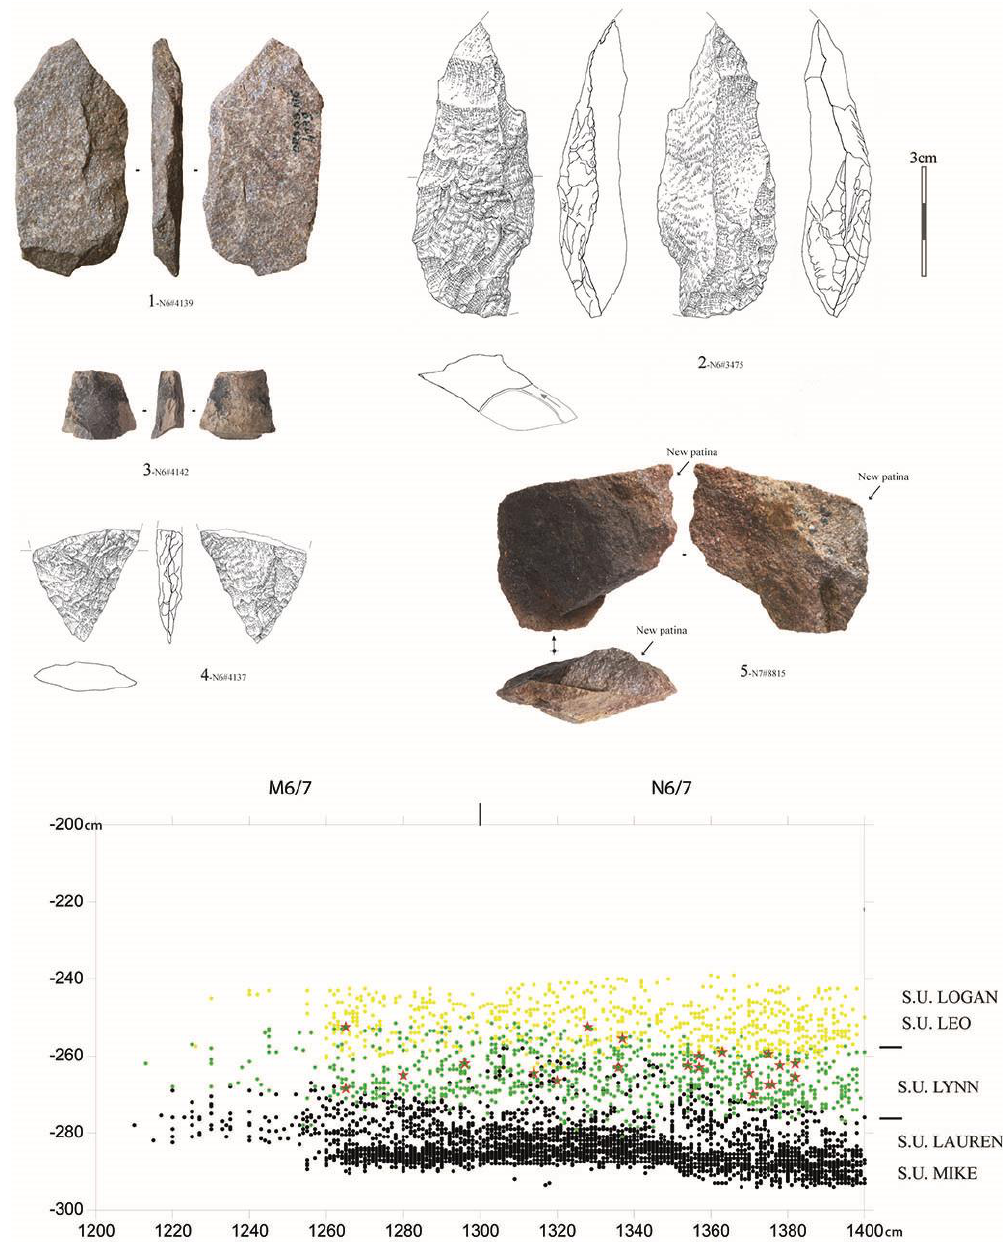
Figure 8 . Bifacial pieces (all made on quartzite, except n°3 made on exotic silcrete) and stratigraphic distribution of all recorded bifacial implements (represented by stars) from the stratigraphic unit Lynn (Diepkloof Rock Shelter). N°1: bifacial piece shaped on a quartzite slab and broken at an early stage of the manufacture. N°2: bifacial piece broken during manufacture. N°3: mesial fragment of a bifacial piece. N°4: proximal fragment of a bifacial piece. N°5: initial shaping of a quartzite flake broken at an early